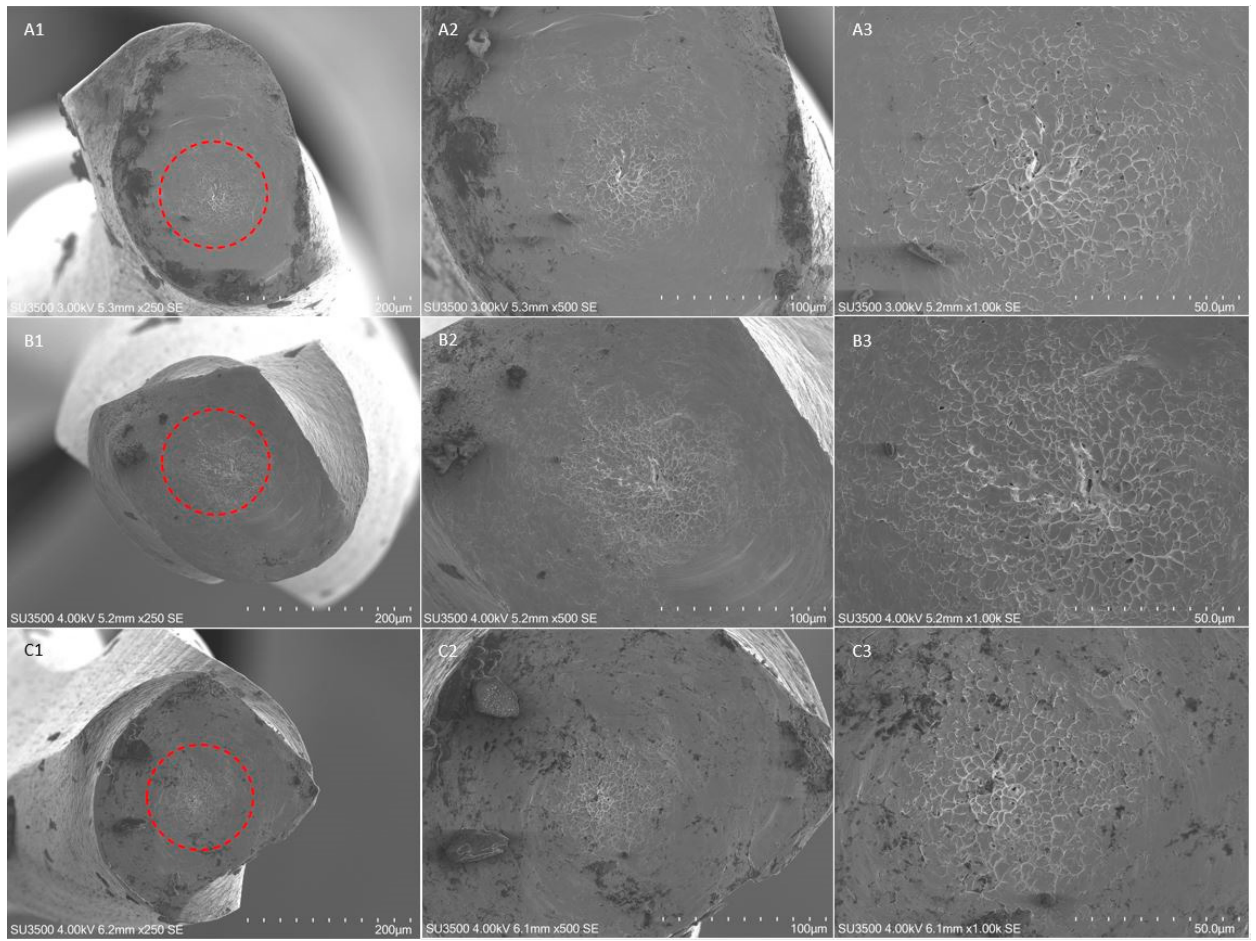
Figure 2. SEM images of fractured surface of three samples of F-One Blue 25/04 in a transversal view at different magnification after torsional fatigue testing. ( A1-A3 ) Figures represent SEM images of instruments fractured after torsional test performed with a straight insertion in the artificial canal, respectively at 250x, 500x and 1000x magnification; ( B1-B3 ) SEM images, respectively at 250x, 500x and 1000x magnification, after torsional test performed with an insertion angle of 10°; ( C1-C3 ) SEM images, respectively at 250x, 500x and 1000x magnification, after torsional test performed with an insertion angle of 20°. The concentric circular abrasion marks and fibrous dimples near the center of rotation evidenced by the red circumferential lines are clearly represented in all samples despite the different angle of insertion.